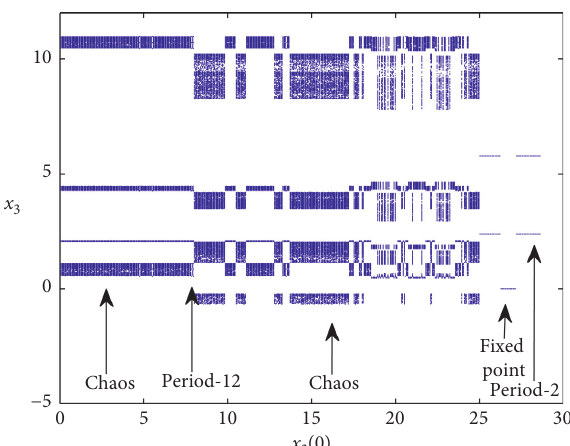
Figure 10: Bifurcation like sequence showing local maxima of the coordinate x 0 ≤ x ( 0 ) ≤ 30, with a � 1 . 8, b � 3 . 8, c � 2 . 5442, d � 1 . 35, and e � 14 . 85. It can be observed the coexistence of ten periodic, chaotic, and point